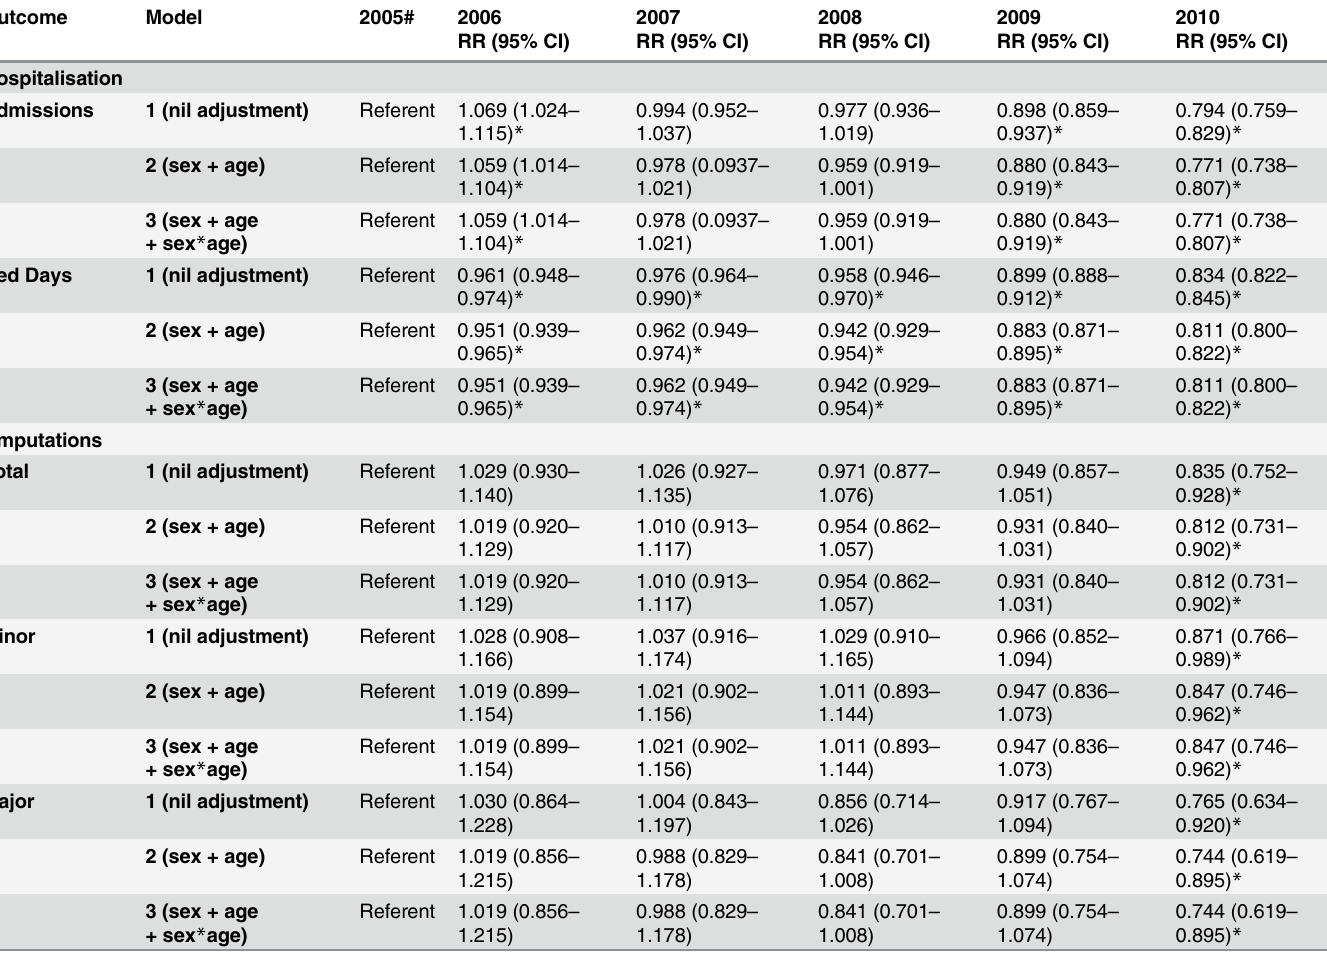
Table 4. Rate ratios of hospitalisation (admissions and occupied bed days) and amputation (total, minor and major) cases in Queensland from 2005 to 2010 with and without adjustment for sex, age and sex * age groups: results from Poisson regression models using calendar year as a cate- gorical